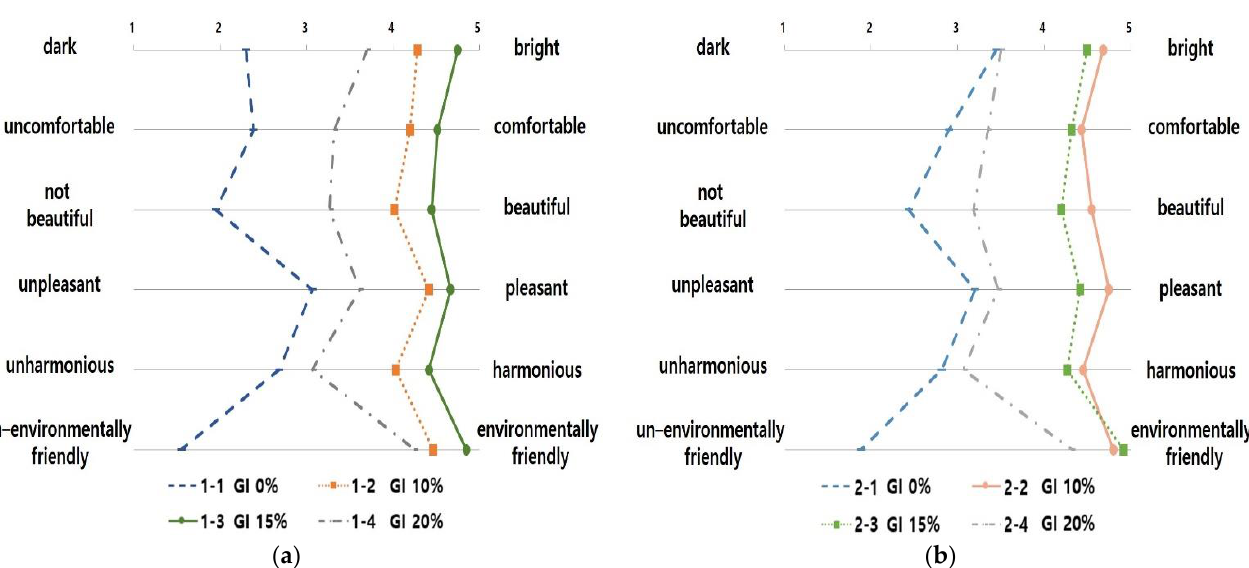
Figure 4. The Graph of Space Image Differences in Interior Landscape Models According to the GI: ( a ) The Graph of Space Image Differences in Underground Subway Interior Landscape Models According to the GI; ( b ) The Graph of Space Image Differences in Ground Subway Interior Landscape Models According to the GI. Table 10. Space Image Difference Analysis of Interior Landscape Models in Underground Subway According to GI. Space